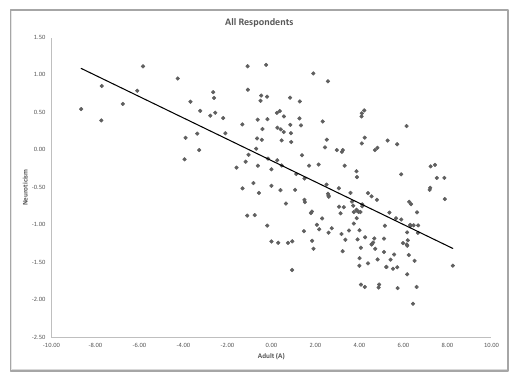
Figure 5. Weak negative r between Free Child (FC) and